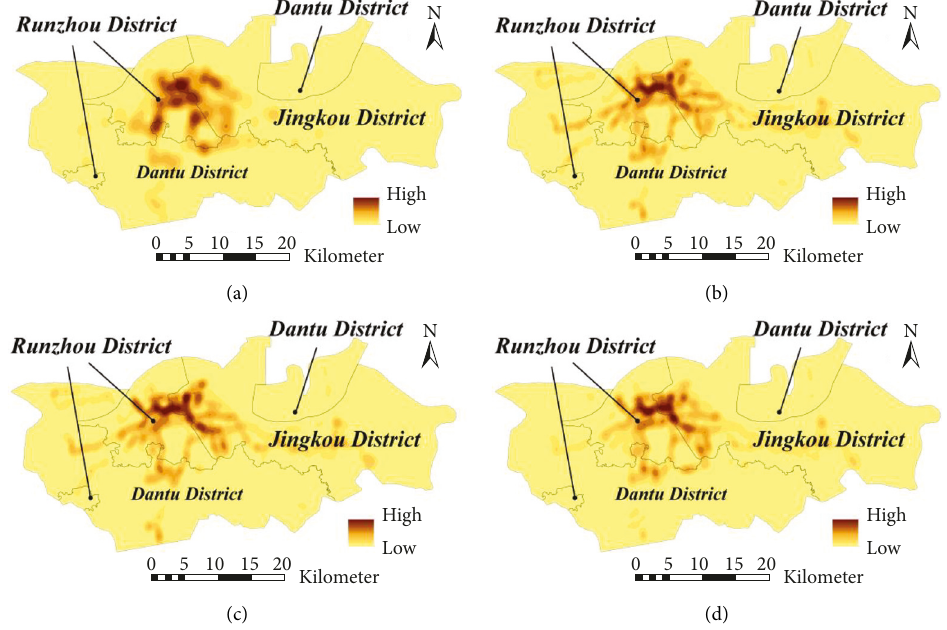
Figure 3: Kernel density by the period. (a) 0:00–6:00. (b) 6:00–12:00. (c) 12:00–18:00. (d)